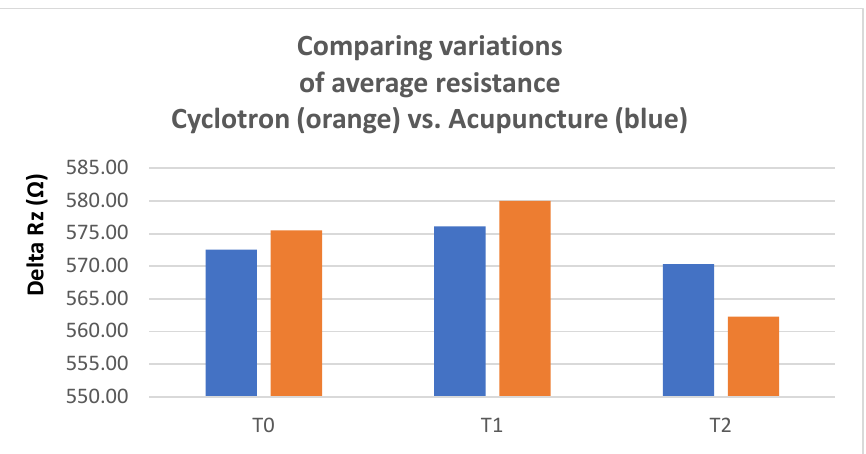
Figure 8. Trends of the average resistance are the same after acupuncture and after exposures to ion cyclotron emission, compared at the same acupuncture points.